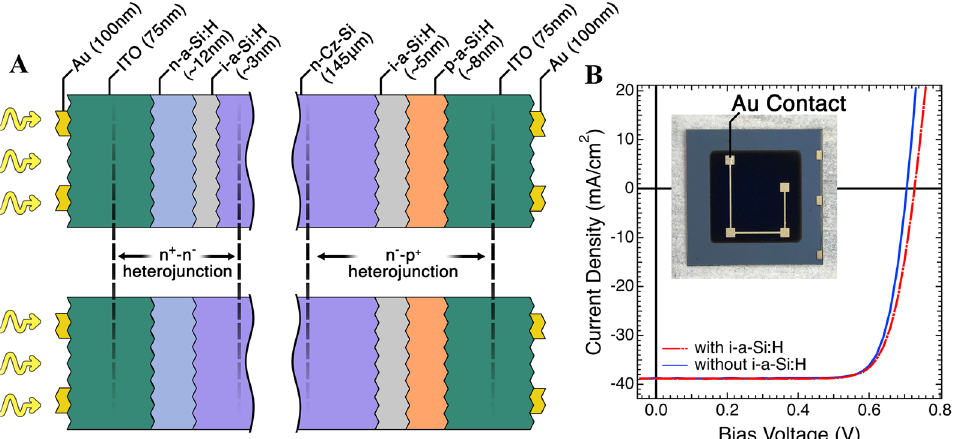
Figure 1. ( A ) Device structure diagram of the SC1-type (top) and SC2-type (bottom) SHJ SCs studied in this work including layer thicknesses. In the SC2 device, the 3 nm-thick intrinsic amorphous layer at the “front side” is omitted. The yellow arrows indicate the direction of illumination. ( B ) J(V) data of representative samples from original wafers under 1 sun illumination; dashed red line represents device with both a-Si layers. The inset shows an image of the device under test; the dark blue active area is ~ 1cm 2